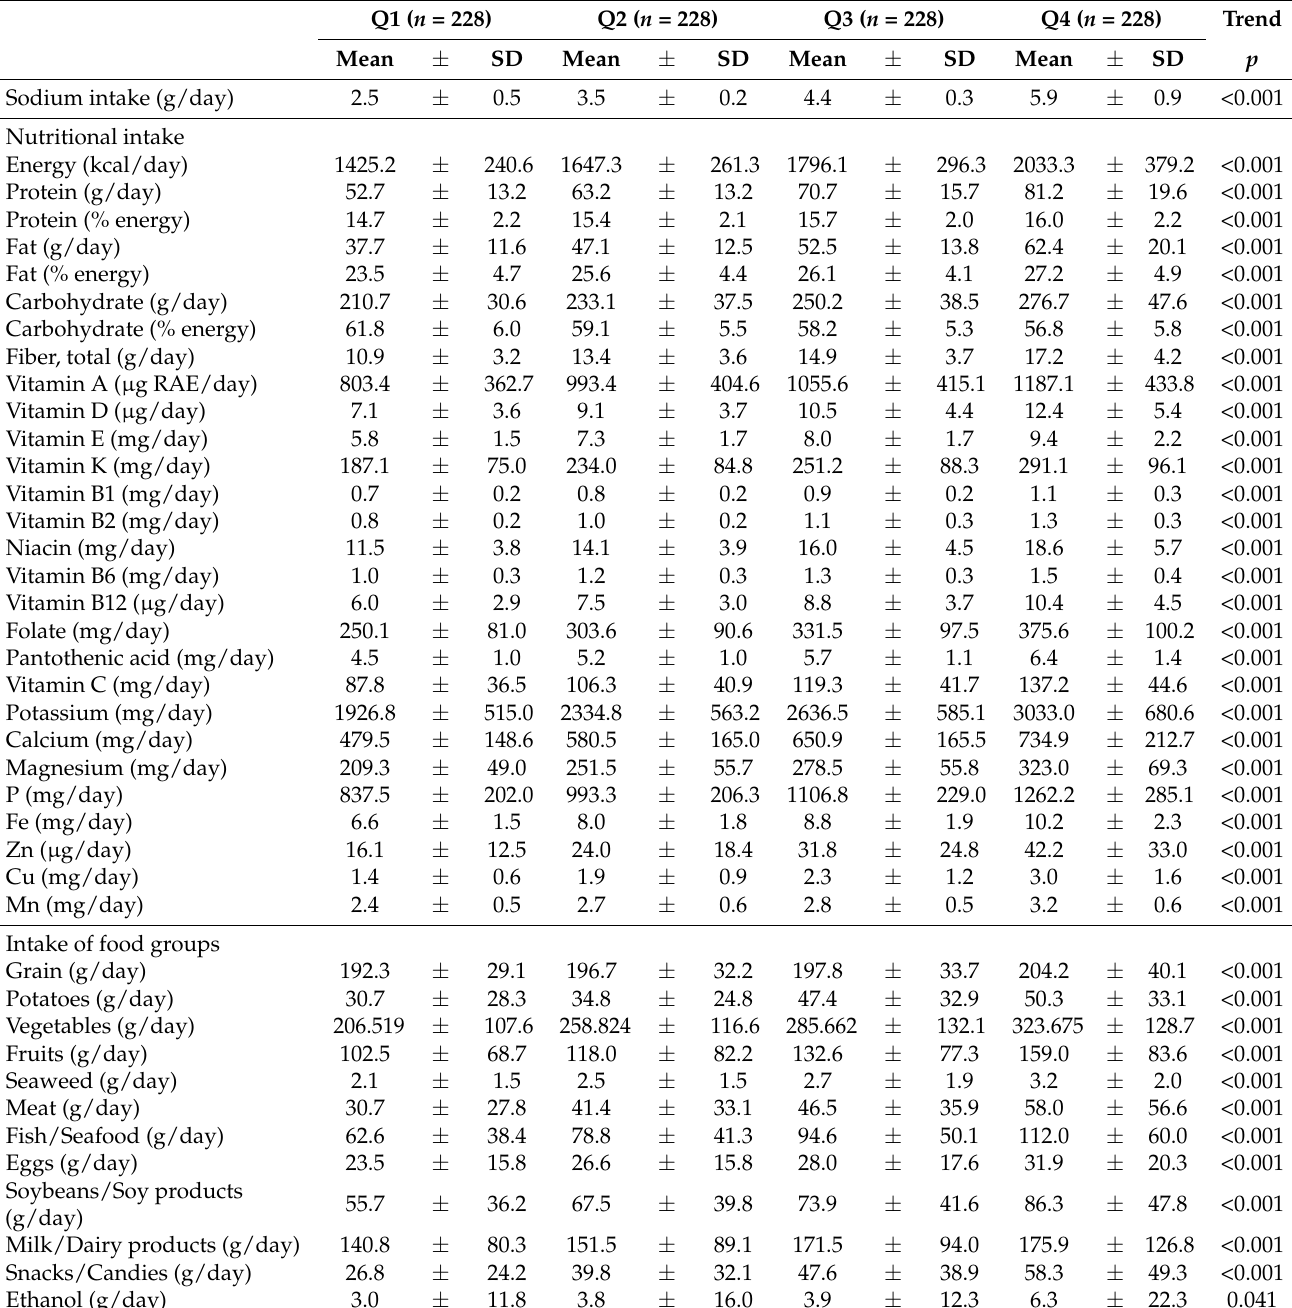
Table 2 shows baseline daily dietary intake by the study patients with type 2 diabetes according to quartiles of sodium intake. Increases in total energy intake were observed from the first to the fourth quartile groups of sodium intake (Q1, 1425.2 kcal; Q2, 1647.3 kcal; Q3, 1796.1 kcal; and Q4, 2033.3 kcal; p < 0.001). The proportions of fat and protein as percentages of the energy supply in the higher sodium intake quartiles (Q2, Q3, and Q4) were significantly increased compared with the lowest sodium intake quartile (Q1), while the proportion of carbohydrates as the percentage of the energy supply were significantly decreased in the Q2, Q3, and Q4 quartiles (all p < 0.001). Patients with higher quartiles of sodium intake had significantly greater intakes of vitamins, minerals, and each food group. Table 2. Baseline food groups and nutritional intakes of the 912 elderly patients with type 2 diabetes according to quartiles of sodium